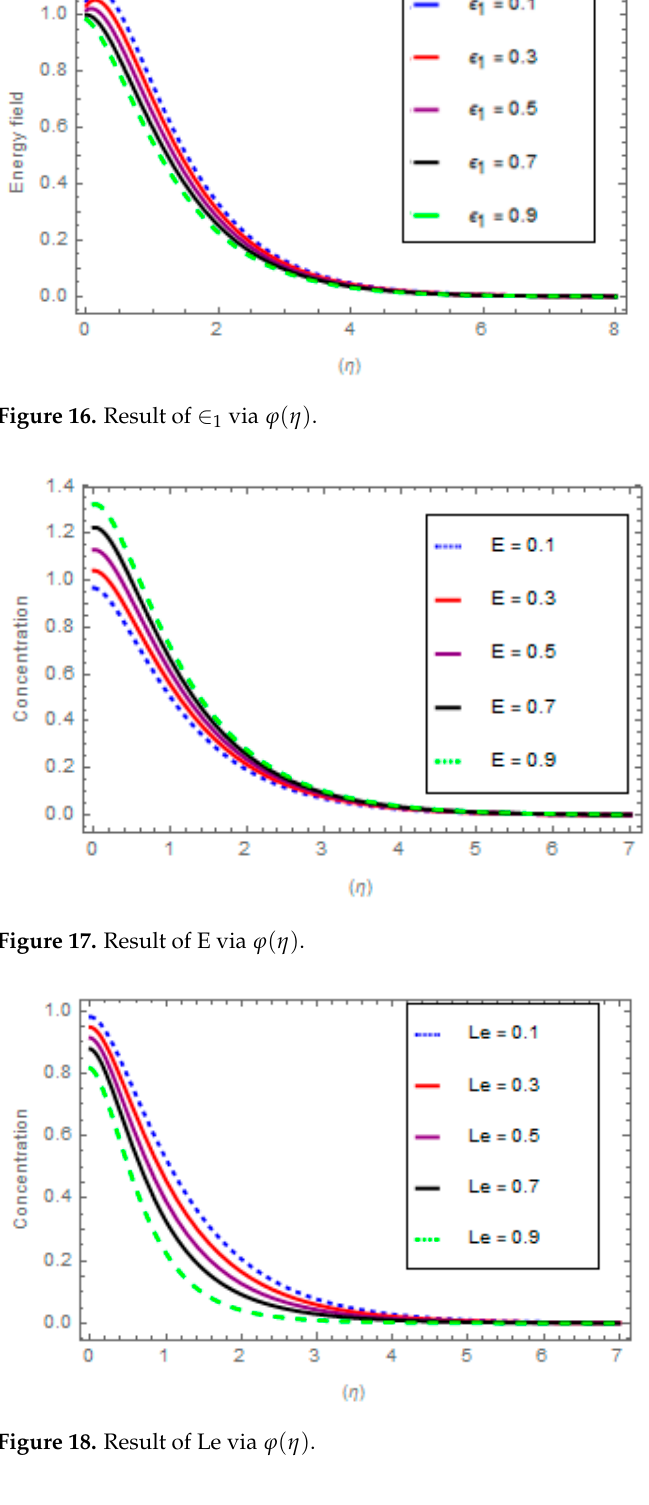
Figure 18. Result of Le via ϕ ( η )